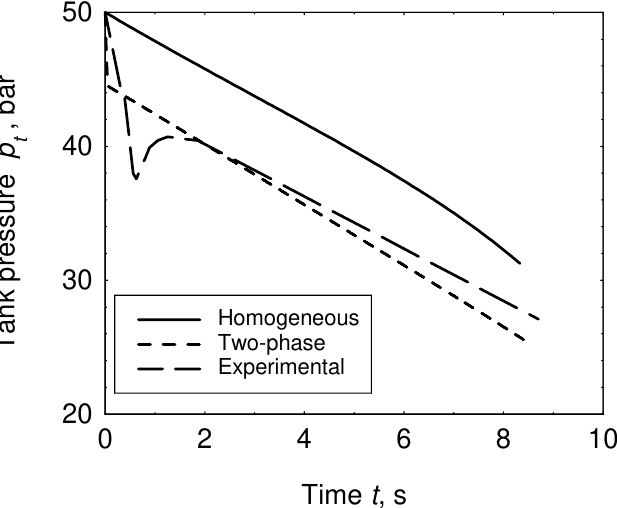
Figure 1. Comparison of NOX tank pressures: calculated vs. experimental data